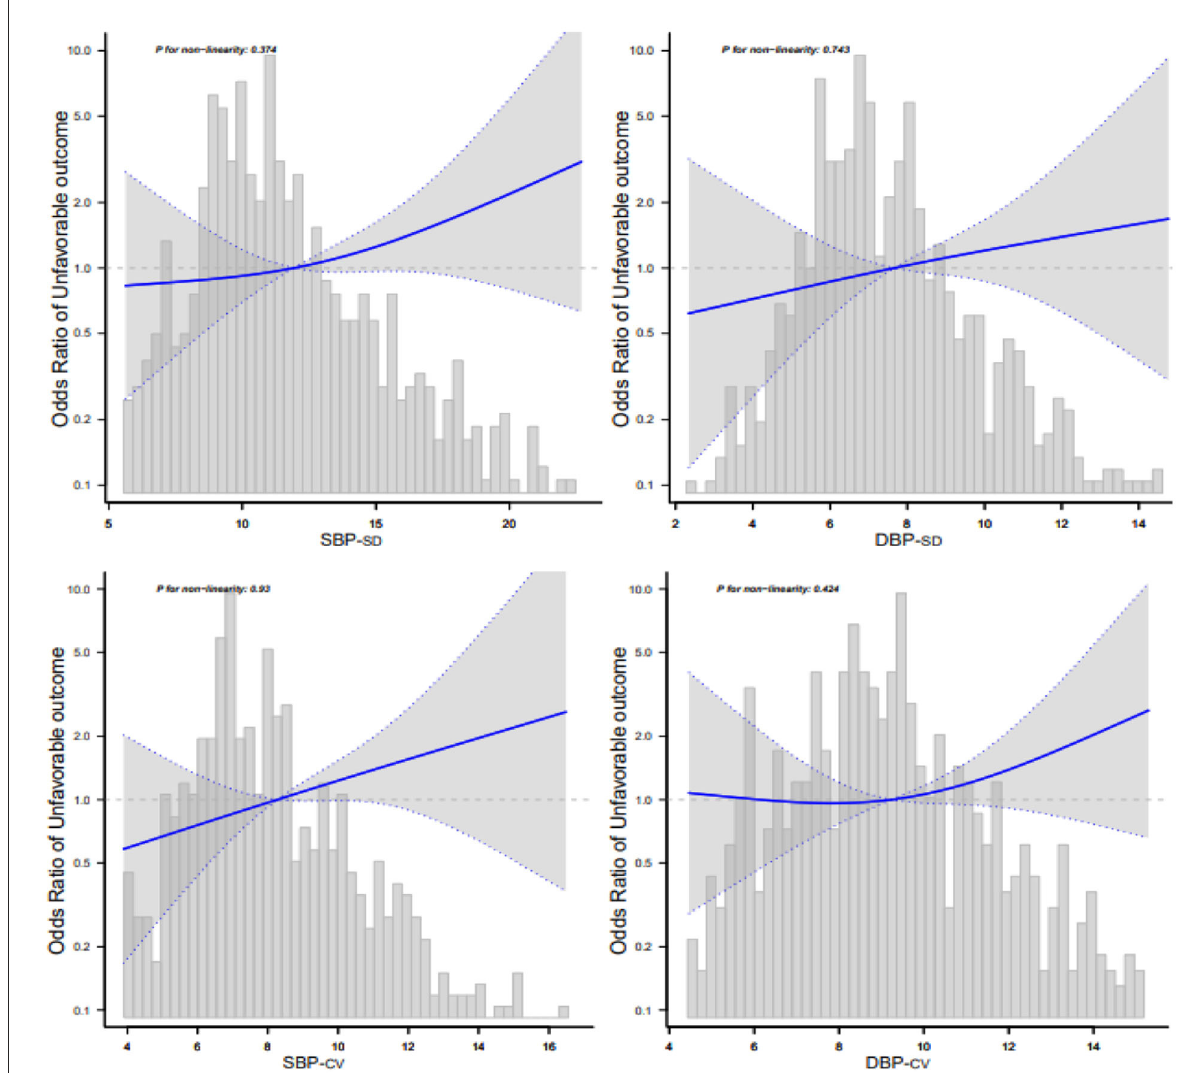
FIGURE3 Relationship between blood pressure variability and 3-month adverse outcomes according to the smooth curve-fitting analysis. Adjusted for age, sex, smoking, alcohol consumption, hypertension, fasting plasma glucose at enrollment, low-density lipoprotein, neutrophils, TOAST classification, NIHSS score at enrollment, END, and mean blood pressure. Only 95% of the data are